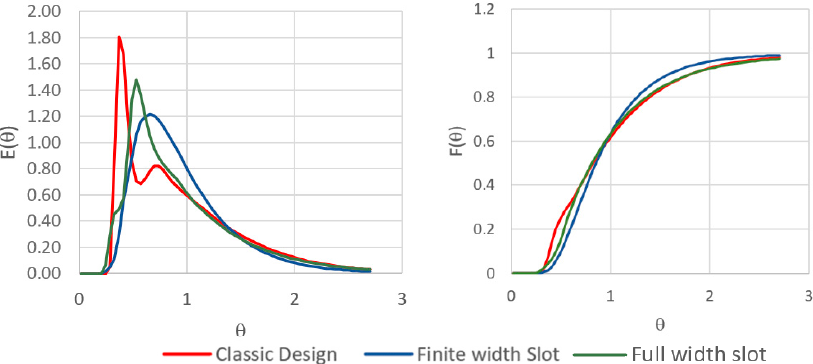
Figure 13. E( θ ) and F( θ ) plots obtained from tracer simulations for contact tank with full width slots